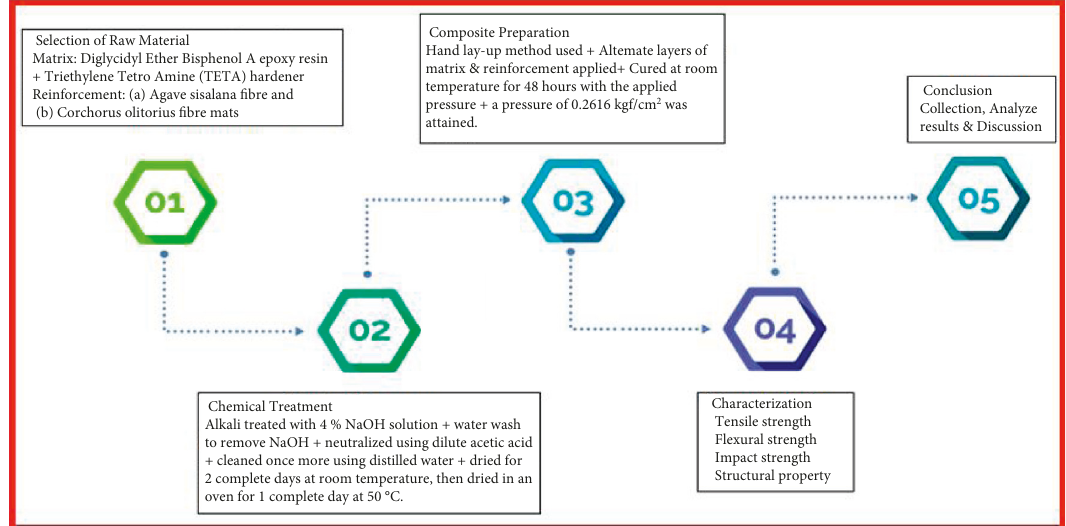
Figure 3: Methodology adopted for the